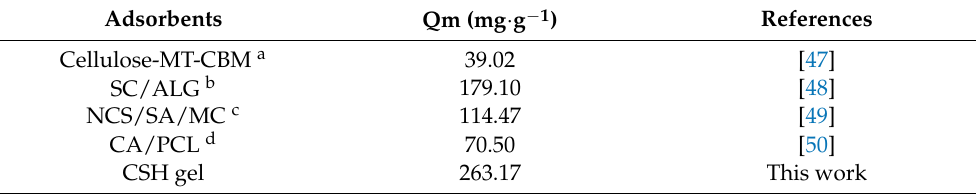
Table 4. Maximum Pb(II) adsorption capacities of the CSH gel and other reported adsorbents.